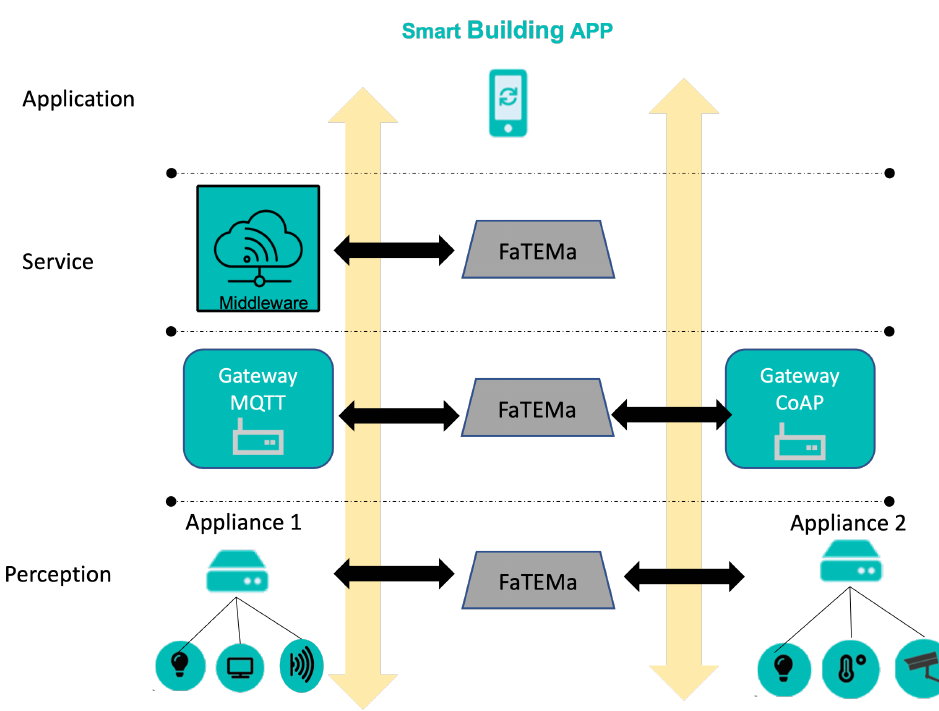
Figure 3. Example of a smart building scenario using